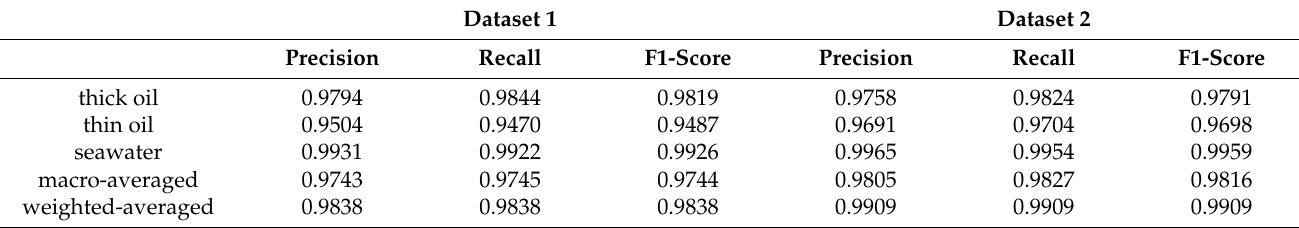
Table 9. The precision, recall, and F1-score for dataset 1 and dataset 2.